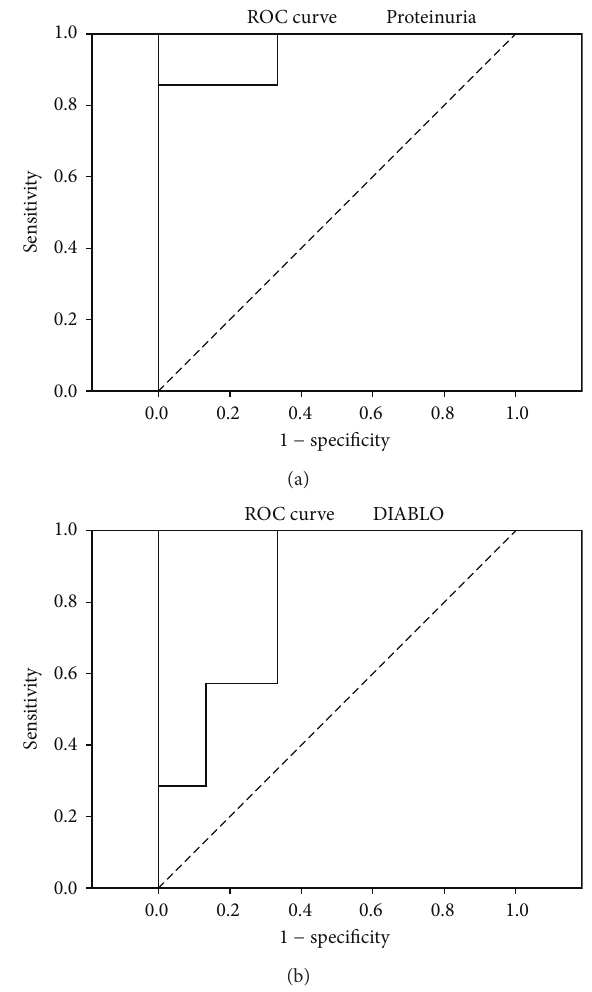
Figure 3: ROC curve analyzing graft failure after CAMR and CTCMR dependent on proteinuria at the time of biopsy (a) or intrarenal expression of DIABLO